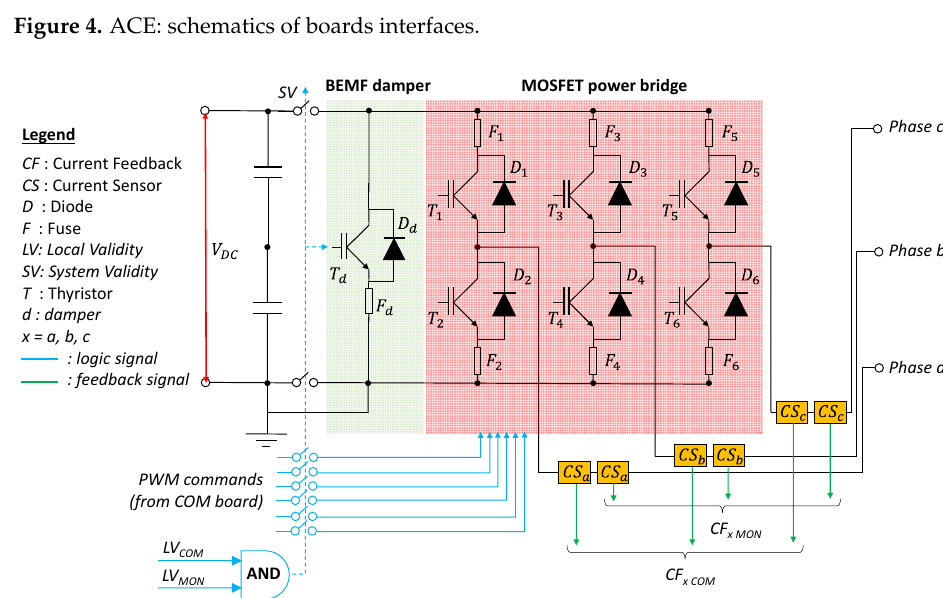
Figure 5. Schematics of the main sections of the PWR board.